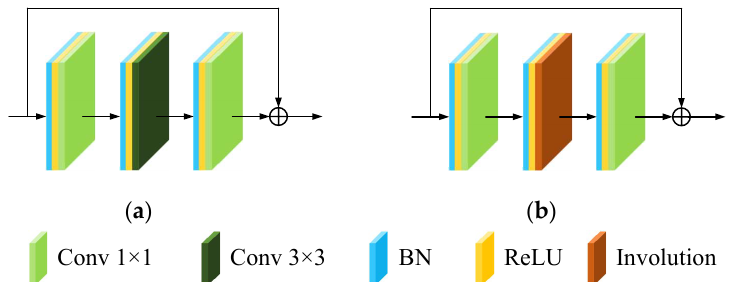
Figure 7. ( a ) Residual block. ( b ) The proposed residual involution (RI)